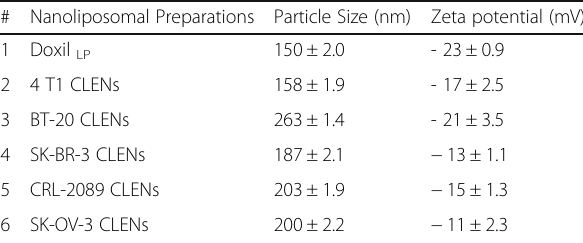
Table 2 Characterization of different CLENs developed from breast